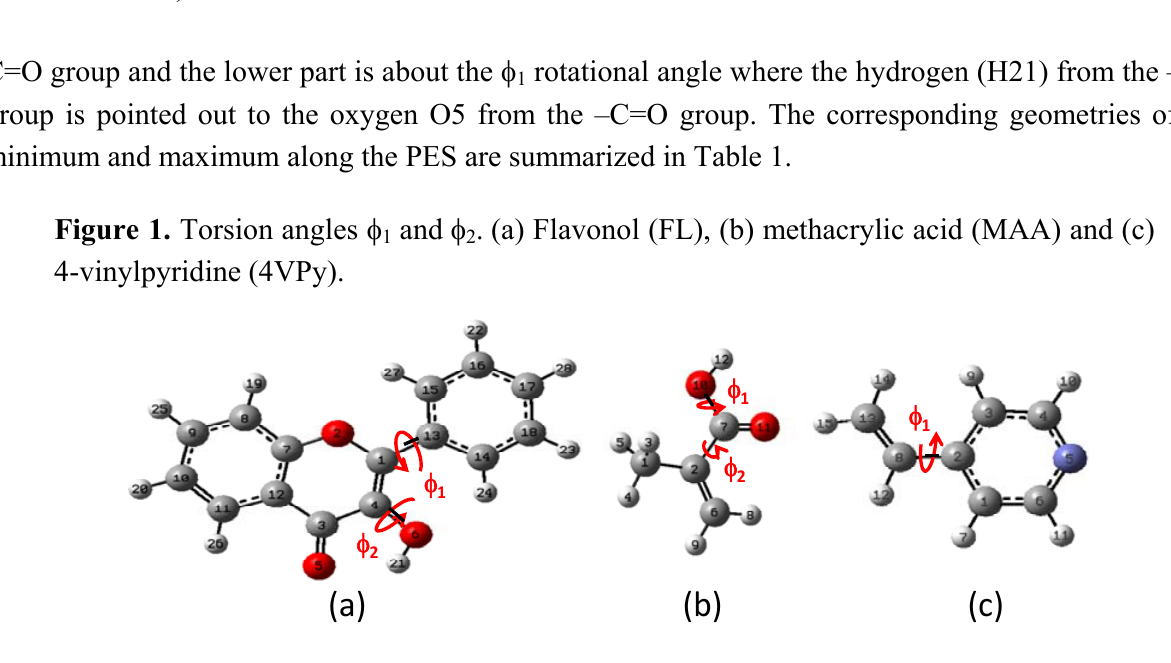
Figure 2. Graphical representation of the PES for flavonol molecule, for the dihedral angles torsion ( φ and φ ), see Figure 1 (a). The corresponding selected geometry structure 2 1 is in Table